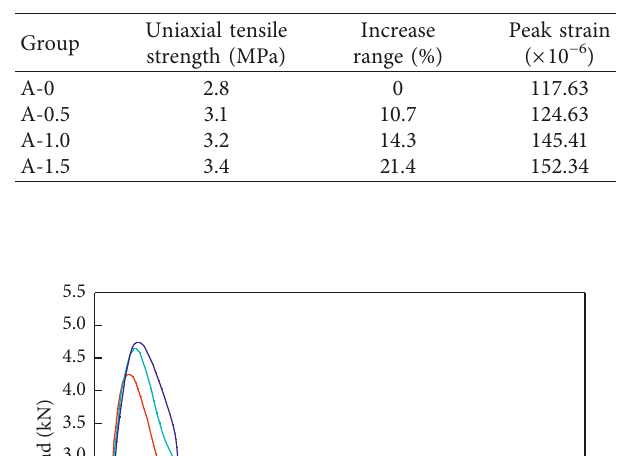
Table 5: Uniaxial tensile test